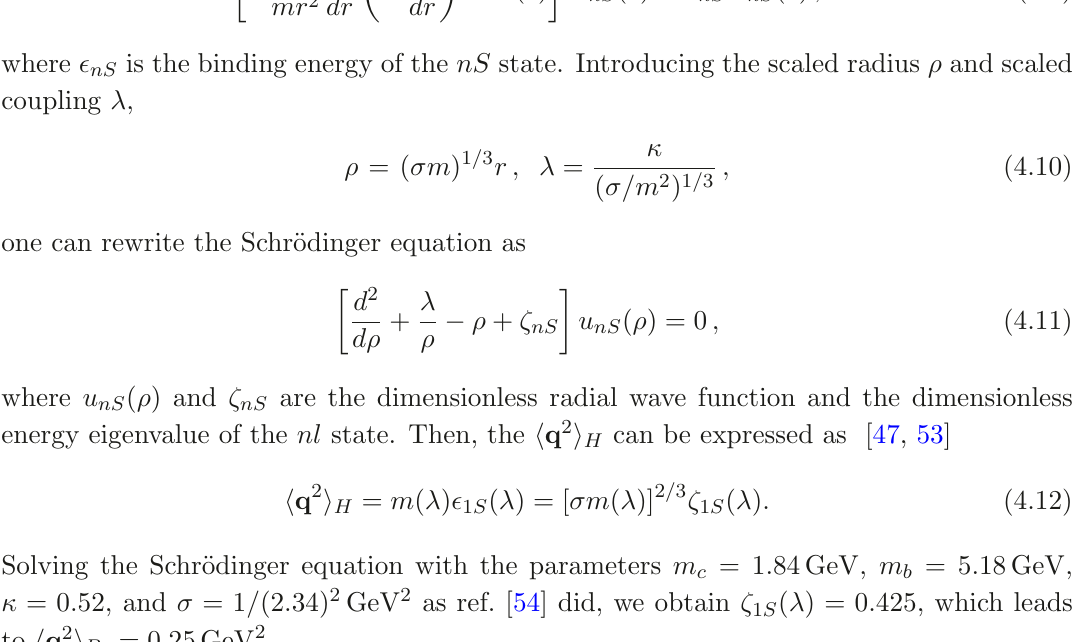
Figure 1 . LCDA ˆ φ P ( x ) for the B c meson, the dashed line denotes the asymptotic form φ ( x ) = 6 x (1 position x 0 = m b / ( m b + m c ) = 0 . 77. The solid line is obtained by including two Gegenbauer moments derived in eqs. (4.4a) and